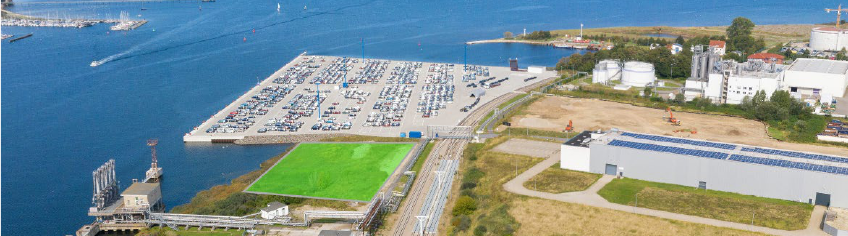
Fig. 2. Space for wind power station [Compiled by the